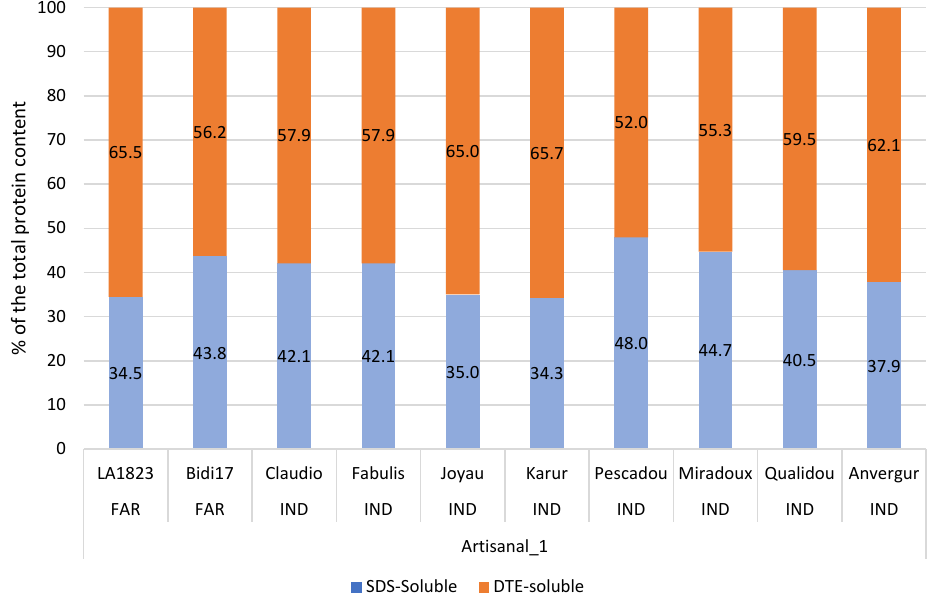
Figure 8. Protein composition measured on freeze-dried cooked pasta from set 1 (H2016 Artisanal 1 process) using SE-HPLC analysis: SDS-soluble and DTE-soluble proteins (as a percentage of the total protein content) according to the cultivar.